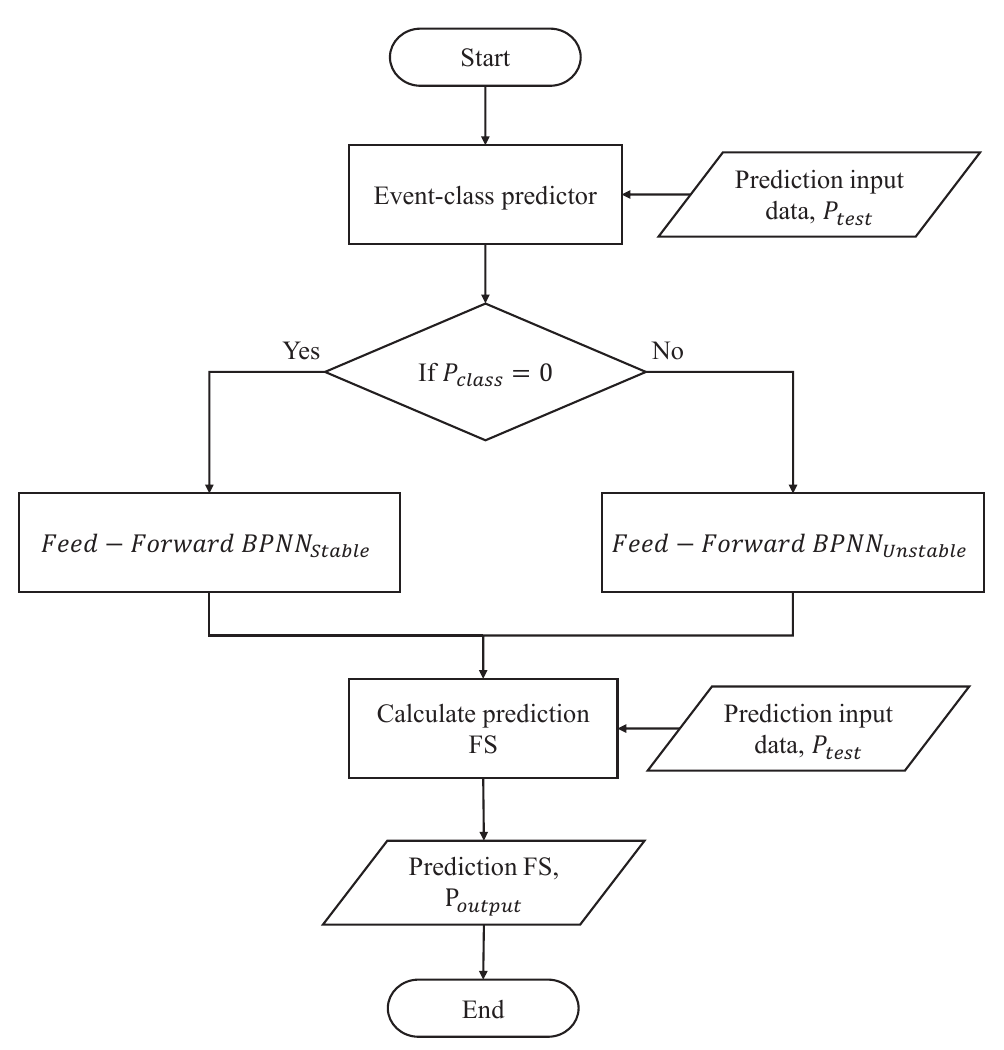
Figure 6. Flow of the switching